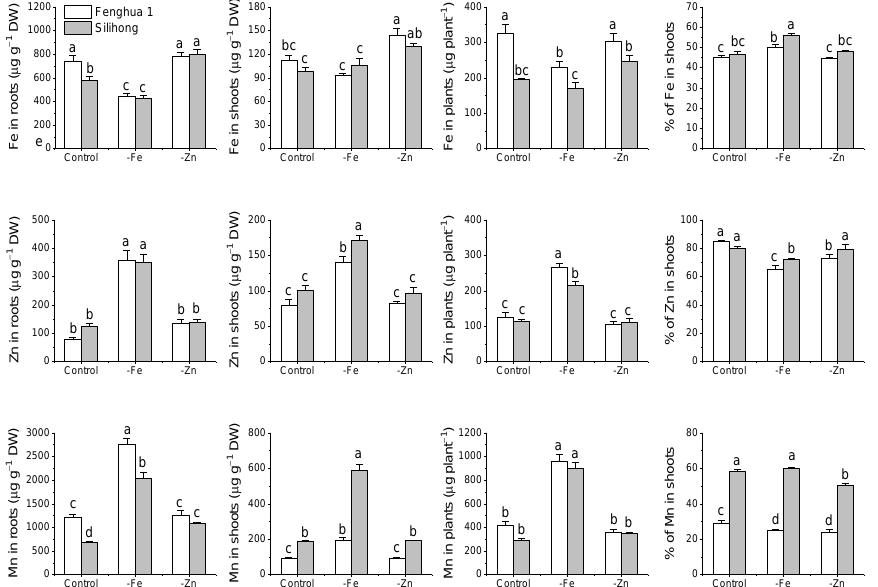
Figure 8. The accumulation and translocation of Fe, Mn and Zn in two peanut cultivars in response to Fe- or Zn-deficiency. Data (means ± SE, n = 4) shared the same letter(s) above the error bars are not significantly different at the 0.05 level based on the Duncan multiple range test.